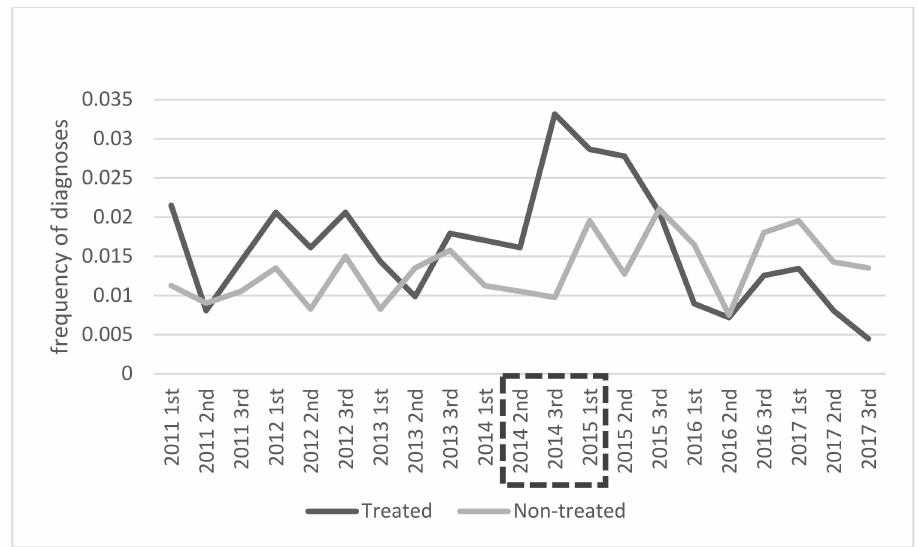
Figure A4. Time-trend frequency of mild asthma diagnoses compared by group; The circled area indicates the intervention